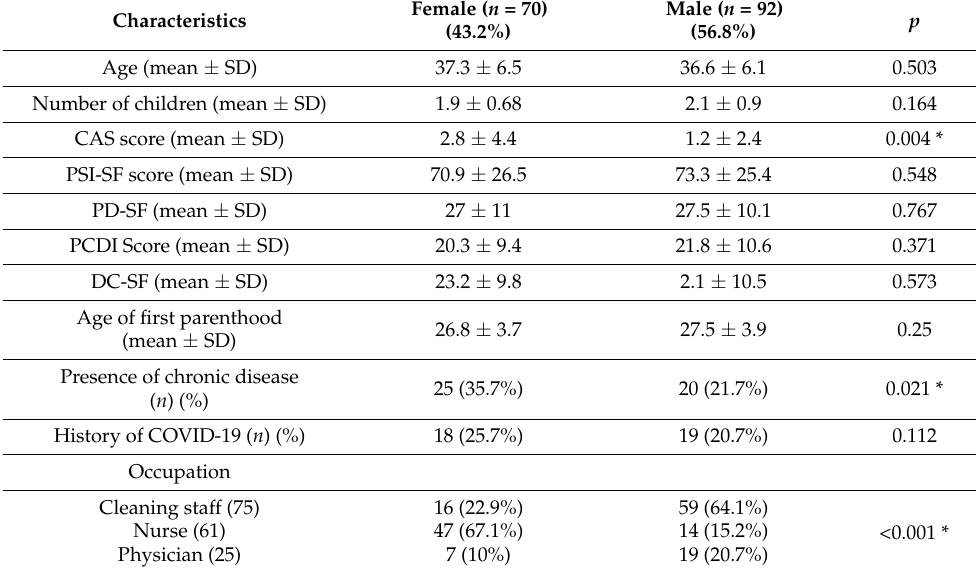
Table 1. Socio-demographic characteristics of health care